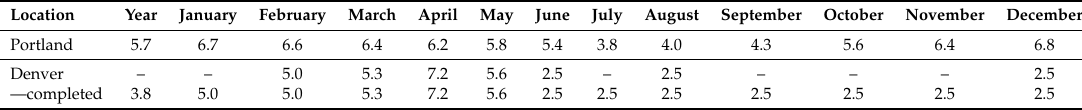
Table 1. Cloudiness measures for the two locations used in